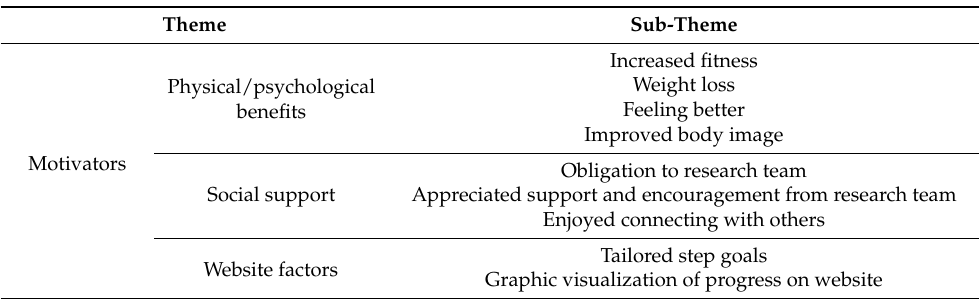
Table 2. Motivators and barriers to